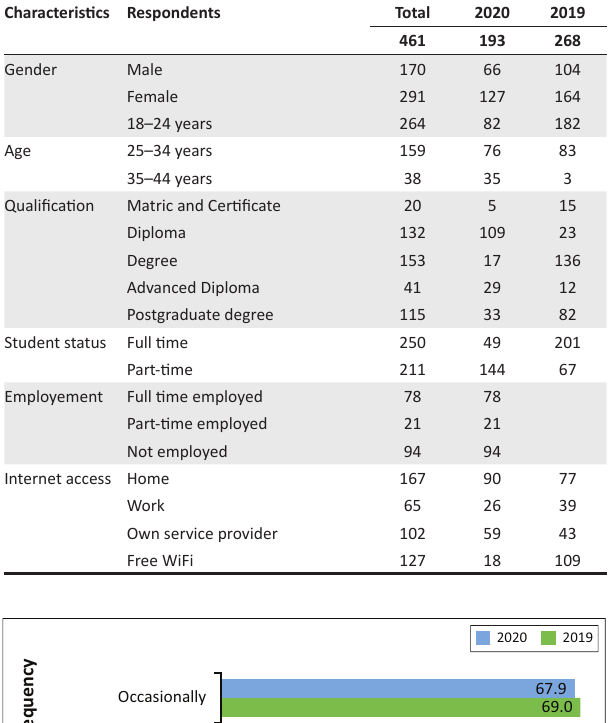
TABLE 1: Respondents profile.